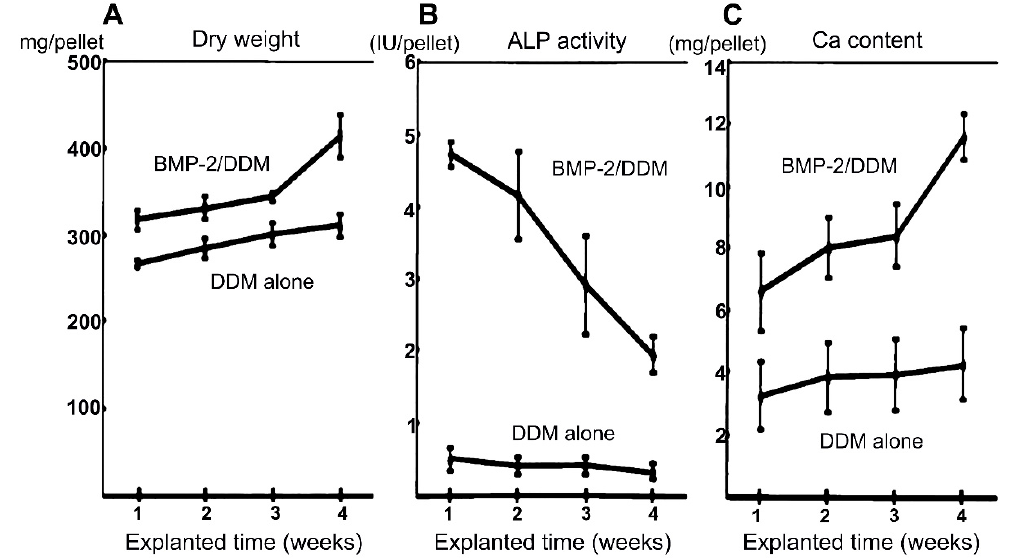
Figure 4. Biochemical changes after implantation in DDM/rhBMP-2 group and DDM group. ( A ) Dry weight (mg/pellet). ( B ) ALP activity (IU/pellet). ( C ) Ca content (mg/pellet). (From Murata [62]